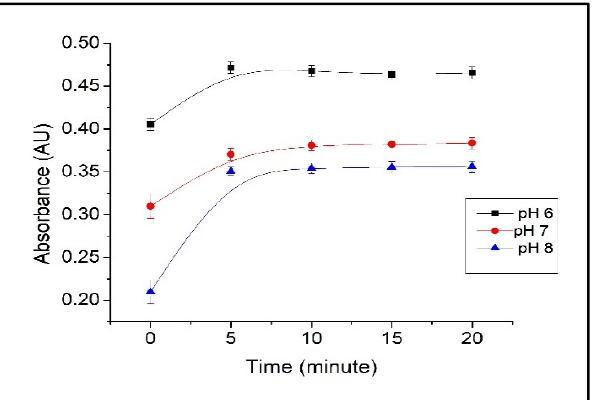
Figure 6. Response times of the prepared sensor measured at pH 6, 7 and 8 at a wavelength of 610 nm.